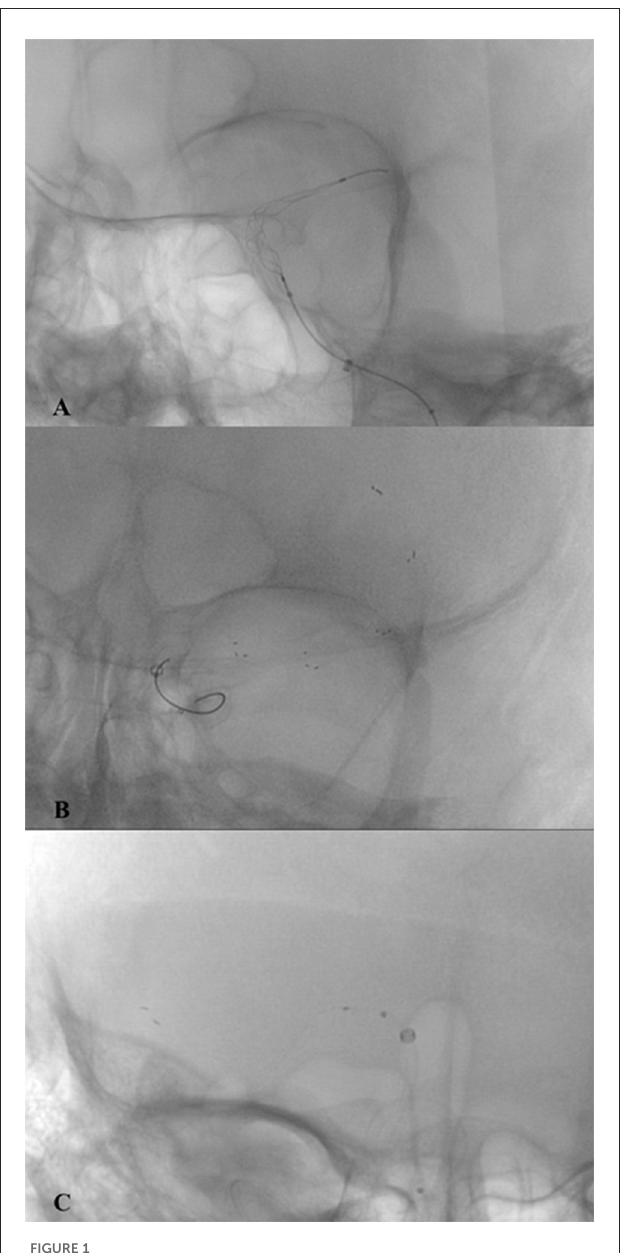
FIGURE2 Differences in the structure of devices (Tigertriever vs. Stent-like SR). (A) Tigertriever 17 (Rapid-medical); (B) Solitaire × 4 × 40mm